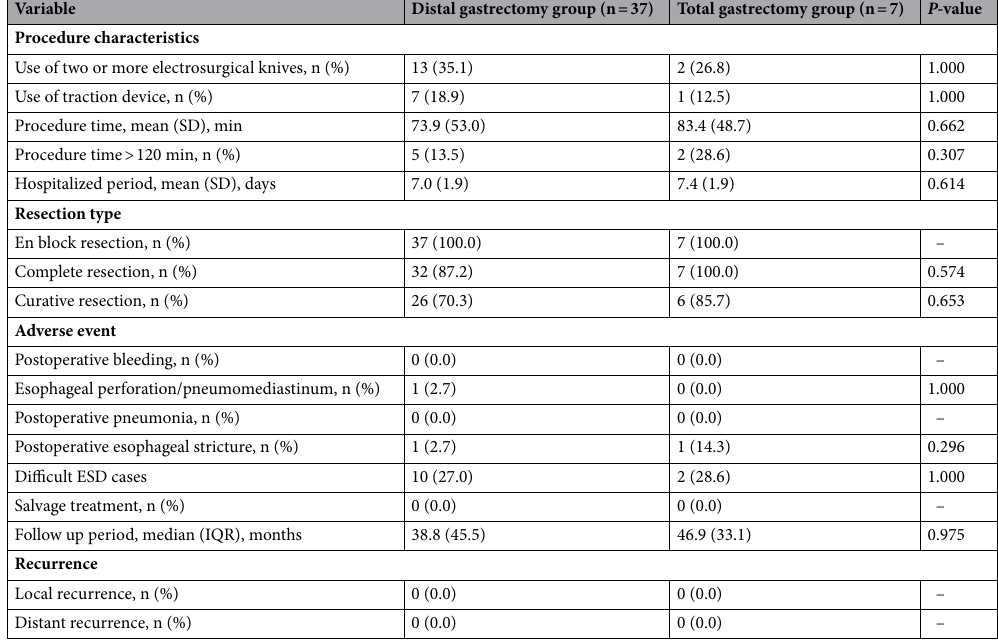
Table 6. Subset analysis of the ESD outcomes according to the operation methods of gastrectomy after propensity-score matching. ESD Endoscopic submucosal dissection, SD Standard deviation, IQR Interquartile